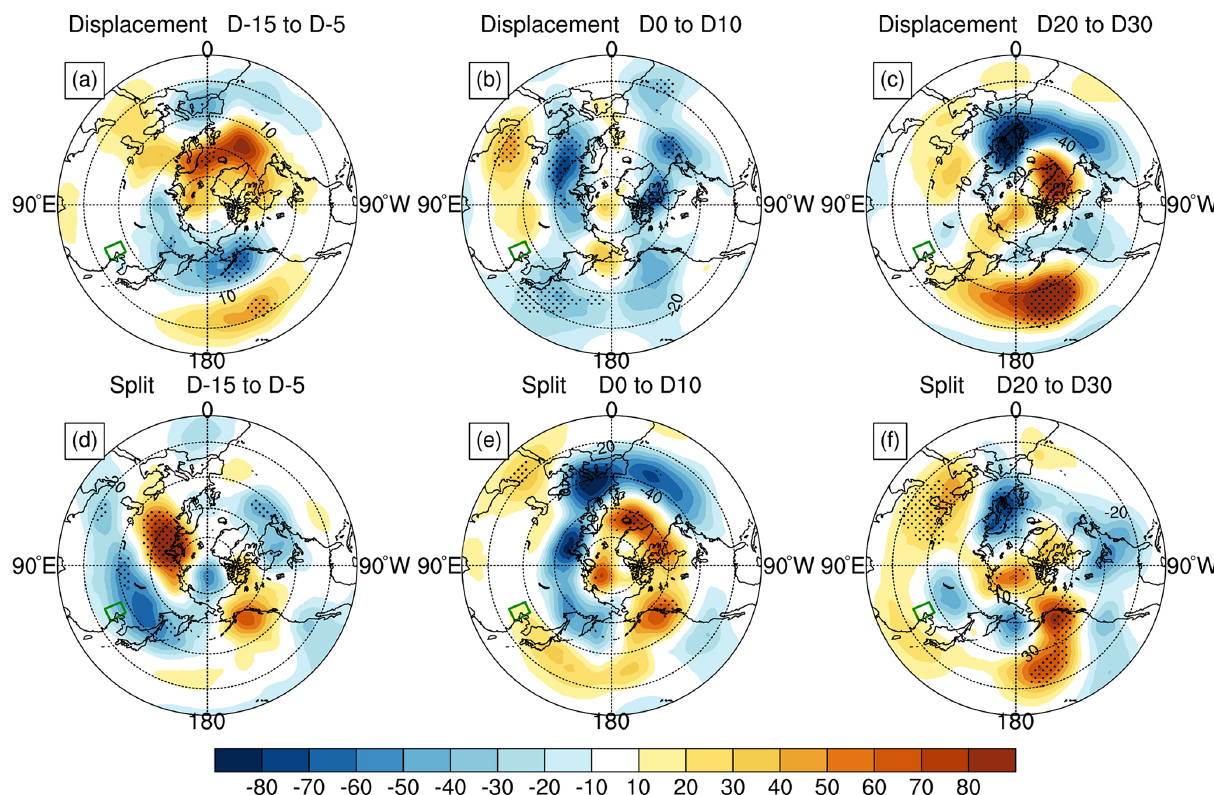
Figure 3. As in Fig. 2 but for composite geopotential height anomalies in the Northern Hemisphere at 500hPa during three periods of the SSW for vortex displacement events (a–c) and vortex split events (d–f) . The dotted regions mark the composite geopotential height anomalies at the 95% confidence level based on the two-sided Student’s t test. The green box marks the focused BTH